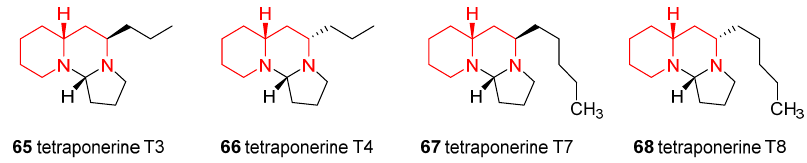
Figure 7. Structures of the tetraponerines T3, T4, T7, and T8.